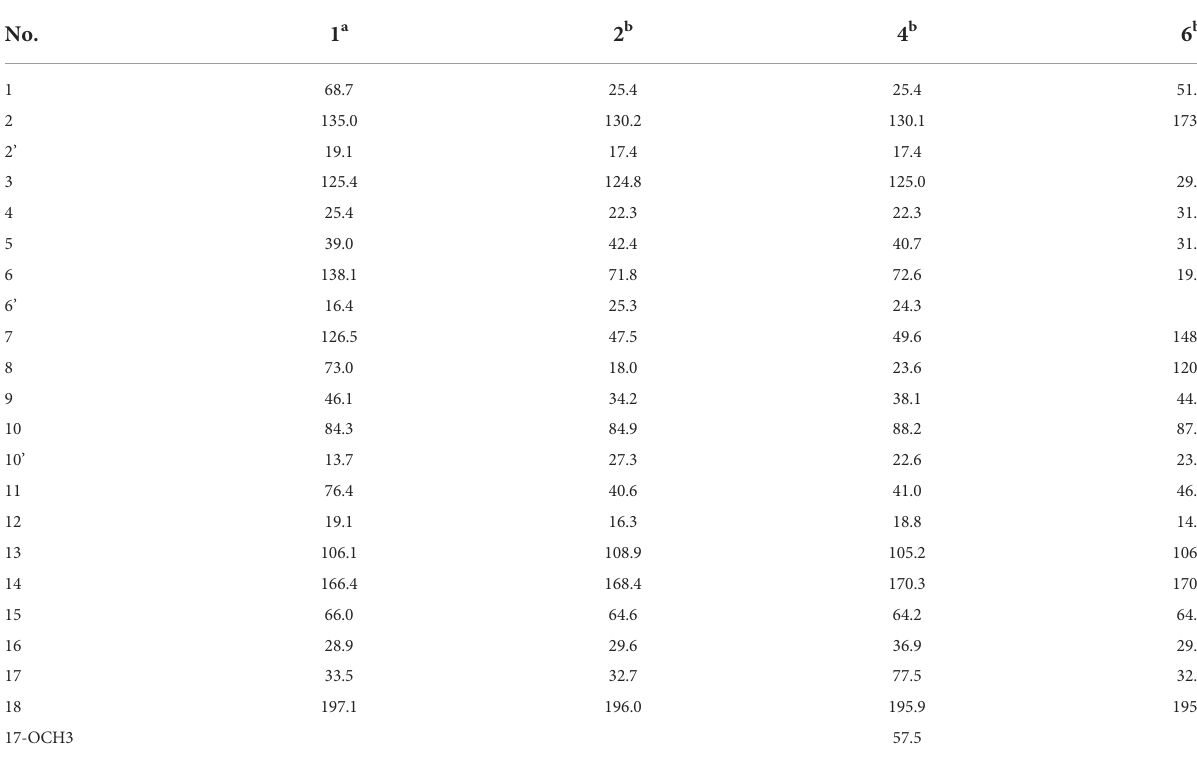
TABLE 2 13 C NMR data for compounds 1 - 2 , 4, and 6